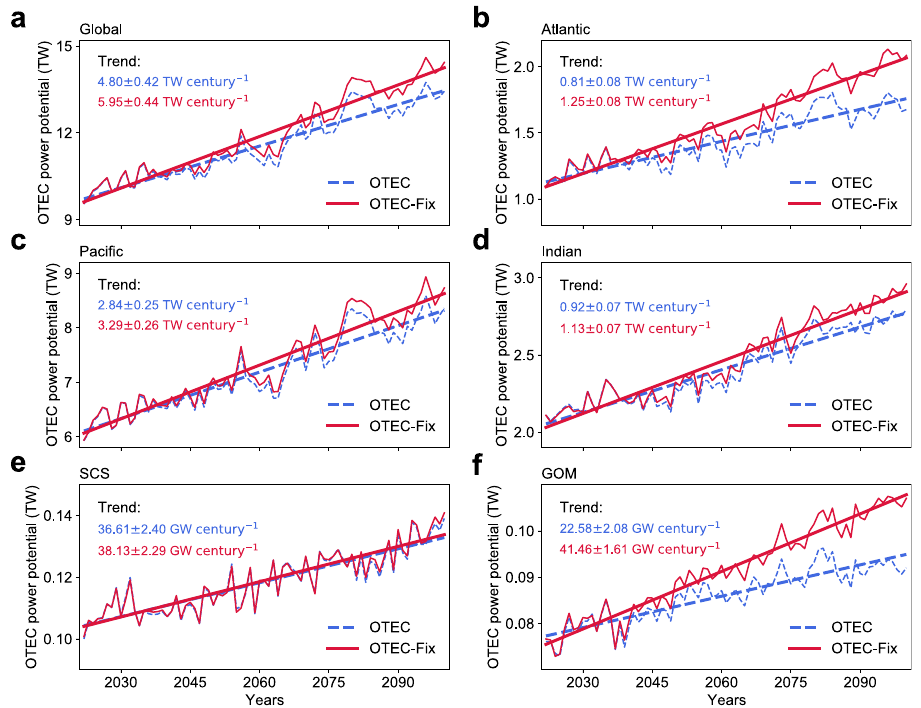
linear trends along with its standard error is shown in the top left corner. b – f Same as a , but for the OTEC power potential and OTEC-Fix power potential in the Atlantic, Paci fi c, Indian Oceans, South China Sea (SCS), and Gulf of Mexico (GOM), respectively. Domain of different oceans is labeled in Supplemen- tary Fig.